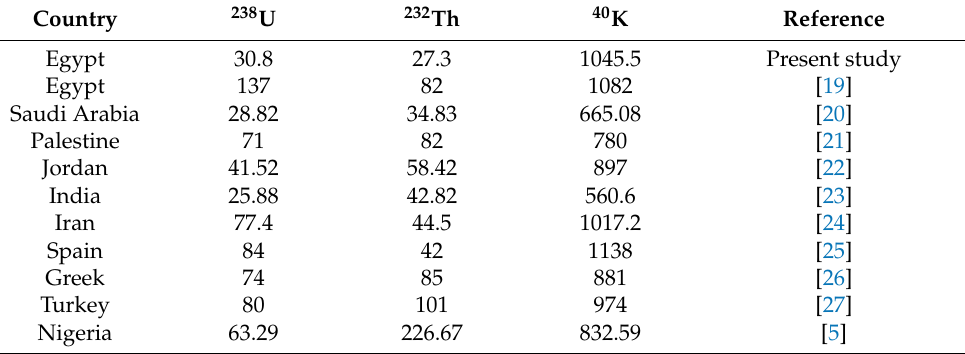
Table 3. Comparison of 238 U, 232 Th and 40 K activity concentration in the Hafafit Area area with numerous world studies.